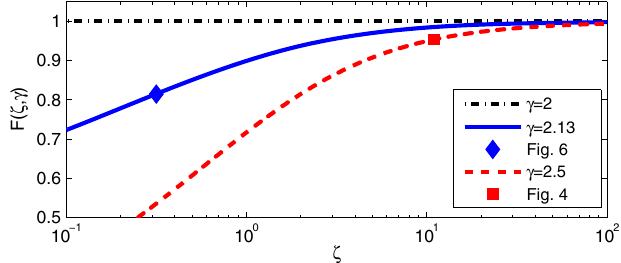
FIG. 8. The function F ð ζ ; γ Þ , as defined in Eq. (A6), for values of γ close to 2. The highlighted points are the parameter values that are relevant to Fig. 4 ( λ z ¼ 11 , γ ¼ 2 . 5 ) and to Fig. 6 ( λ z ¼ 0 . 32 , γ ¼ 2 . 13 ). In all cases of interest, the values of F are close to 1, so we conclude that the one-term expansion used in Eq. (A2) gives a good estimate of the exact steady-state